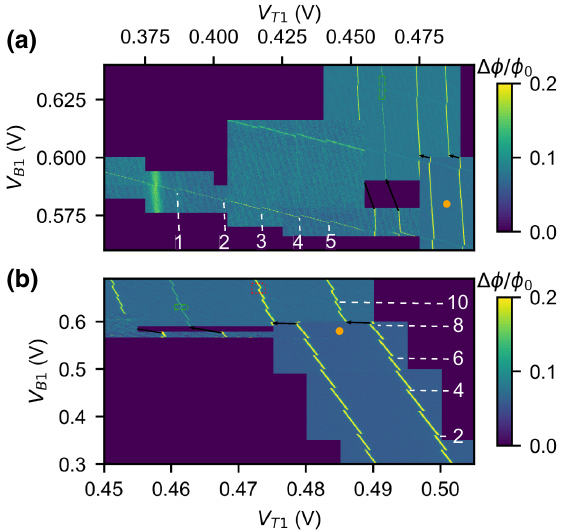
FIG. 12. Determining the electron occupancy. (a) Charge sta- bility plot focusing on a charge transition of the B 1 dot, where we indicate loading of electrons into the T 1 dot with the white dashed lines. (b) Charge stability plot showing a transition of the T 1 dot where we indicate loading of electrons into the B 1 dot. The red-dotted and green-dashed boxes indicate the ICTs inves- tigated in Figs. 2 and 4 respectively, similar to those in Fig. 1(d). An orange marker is included in both plots at the same voltage coordinates ( V T 1 , V B 1 ) = ( 0.485, 0.58 ) V to aid comparison. Due to an extended time period between some of the measurements, there is a variation in the position of T 1-dot charge transitions due to voltage drift; black arrows are used to connect these transitions between the data sets.